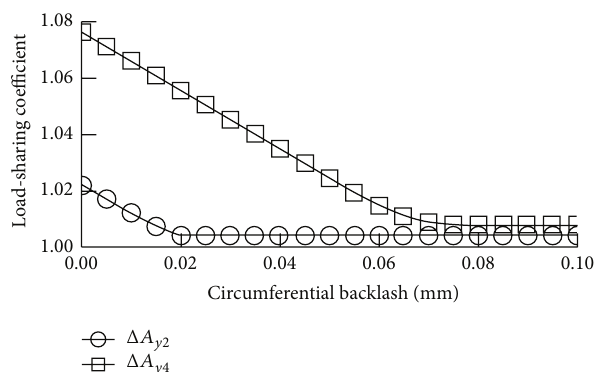
Figure 15: Load-sharing coefficient with a single influence of center distance installation errors.